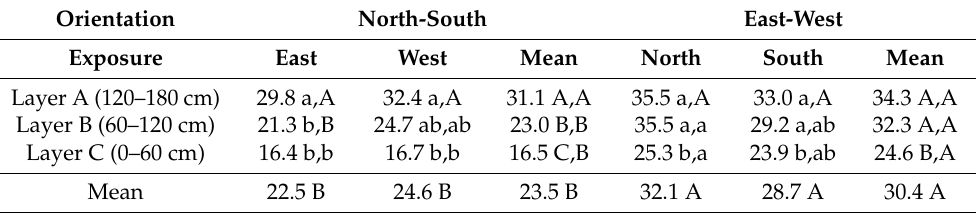
Table 2. Mean number of wood buds per shoot (WB). The first letters denote significant differences between layers for a given exposure; the second letters denote significant differences between exposures for a given layer (SNK test). Lower case letters denote statistical differences with p = 0.05. Capital letters denote statistical differences with p = 0.01.